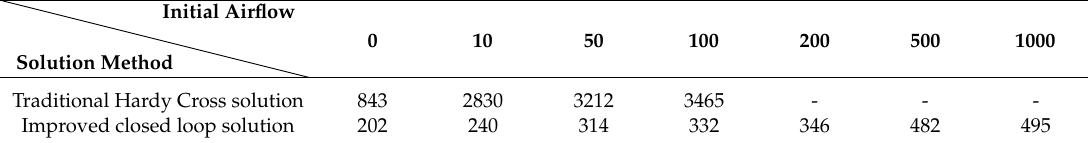
Table 6. Comparison of the iterative number for di ff erent specified initial airflows (m 3 / s) using the traditional Hardy Cross solution method with the improved closed loop solution method.